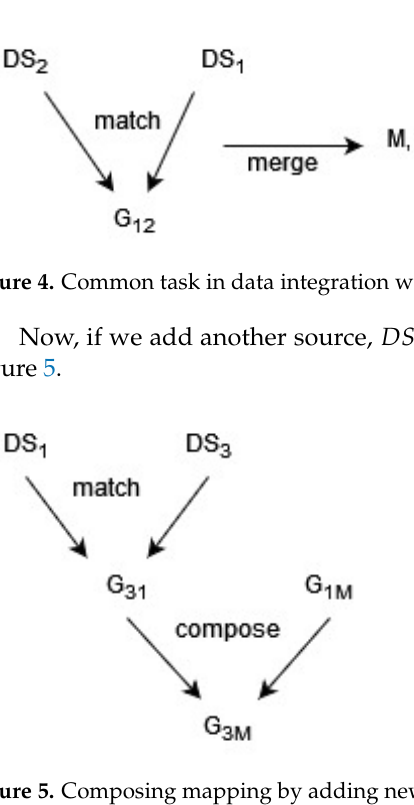
Figure 5. Composing mapping by adding new